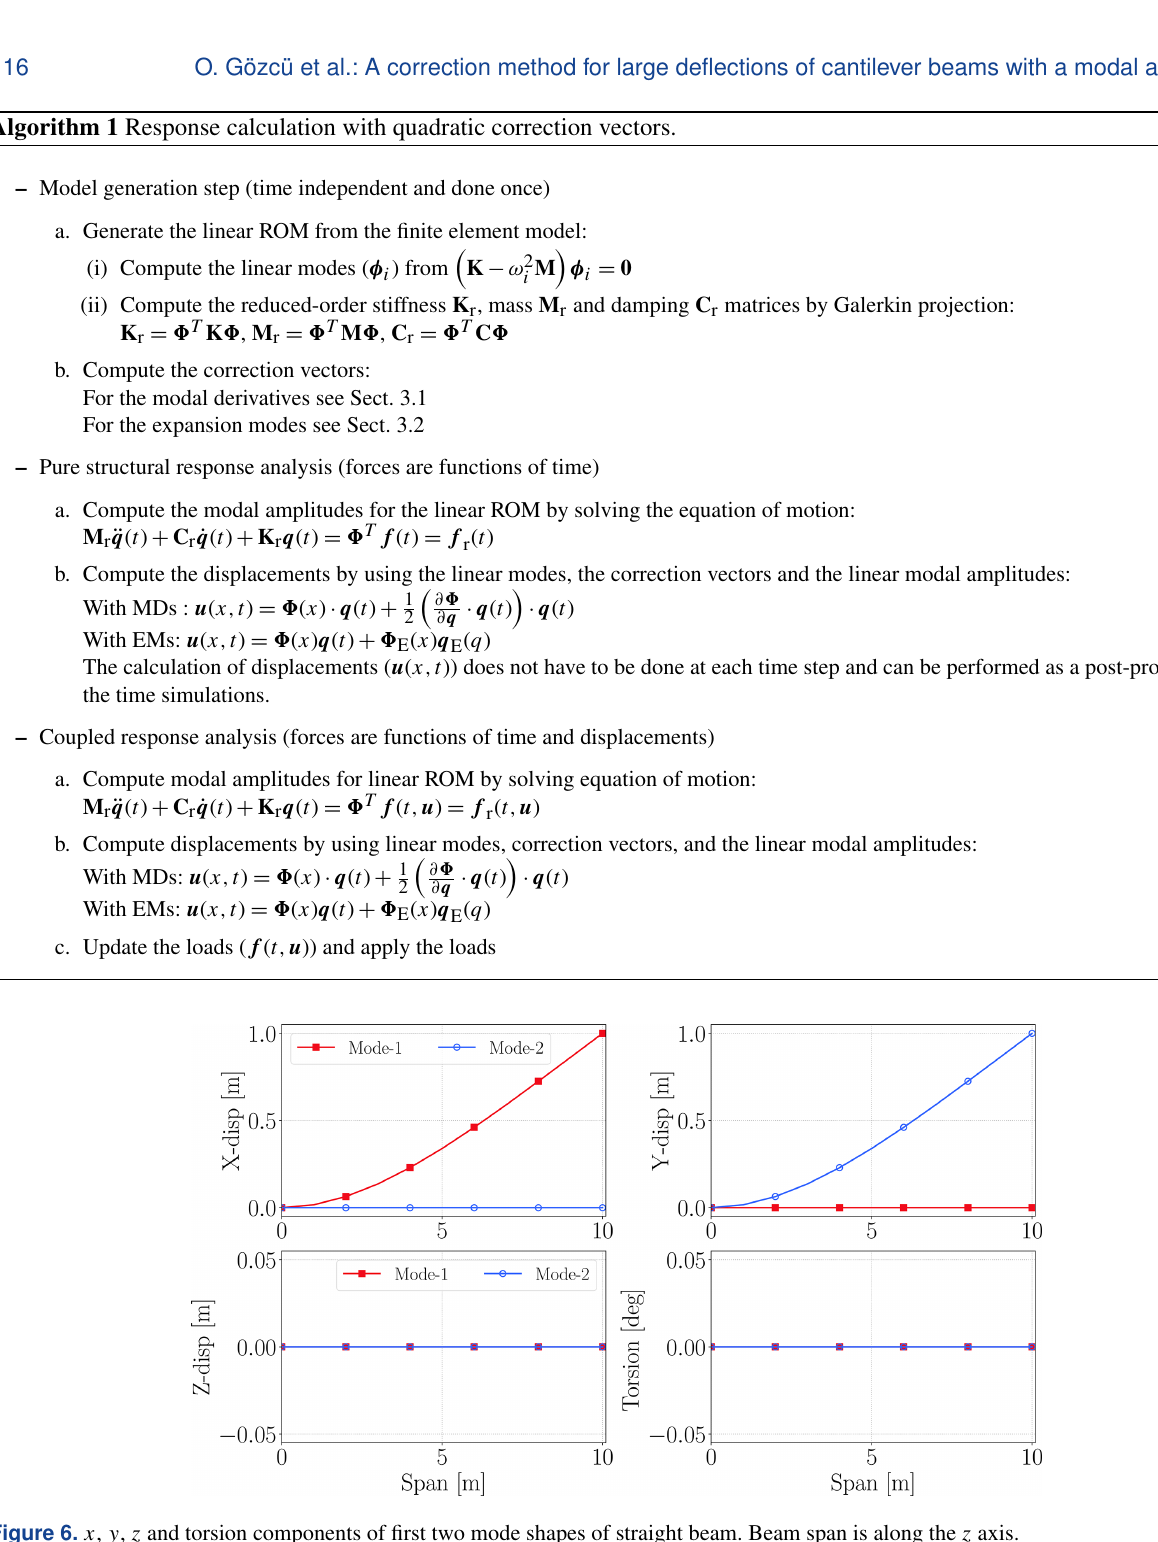
bending ( x ) direction, which is even amplified for secondary effects due to the